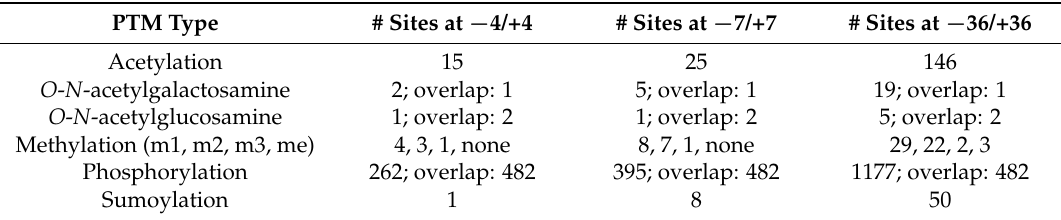
Table 2. Post-translational modifications in the vicinity of CK2 1 target sites retrieved from PhosphoSitePlus (accessed August